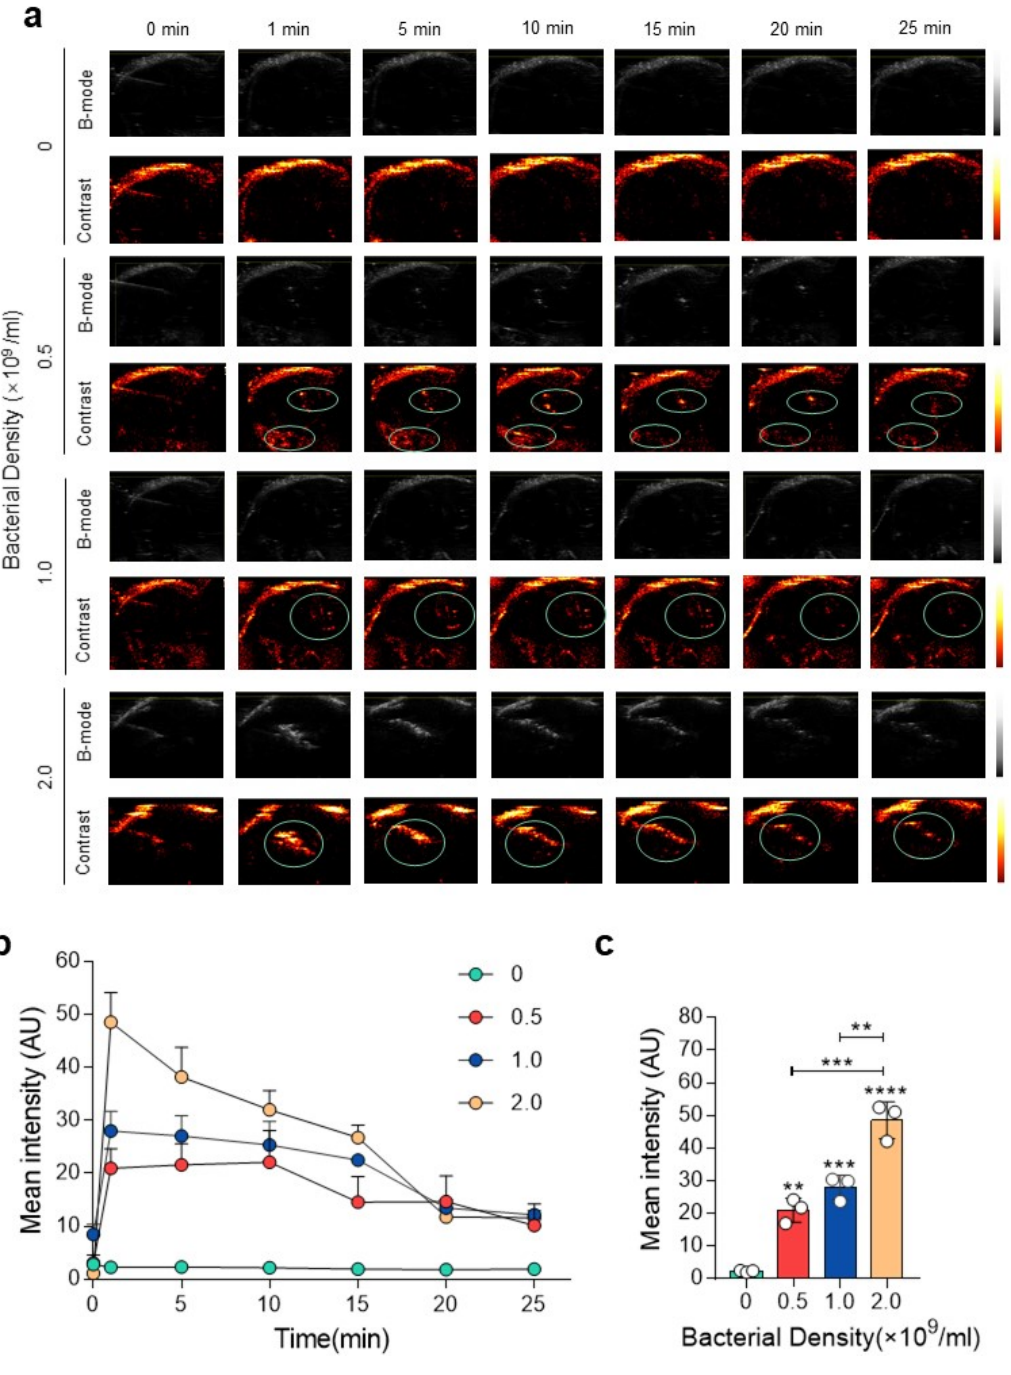
Figure 4. In vivo ultrasound imaging of GVs-miRFP680 MG1655. ( a ) In vivo acoustic imaging of the tumor was taken at different times after intratumoral injection of GVs-miRFP680 MG1655 with different bacterium concentrations (0, 0.5 × 10 9 , 1.0 × 10 9 , and 2.0 × 10 9 CFU/mL). ( b , c ) Quantitative analysis of the acoustic imaging signal in ( a ). Data represent the mean ± SD from 3 independent experiments. **** p < 0.0001 vs. control. *** p < 0.001 vs. control. ** p < 0.01 vs. control.